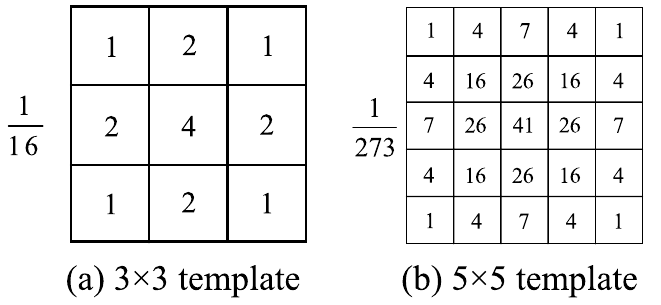
Figure 1. Gaussian convolution